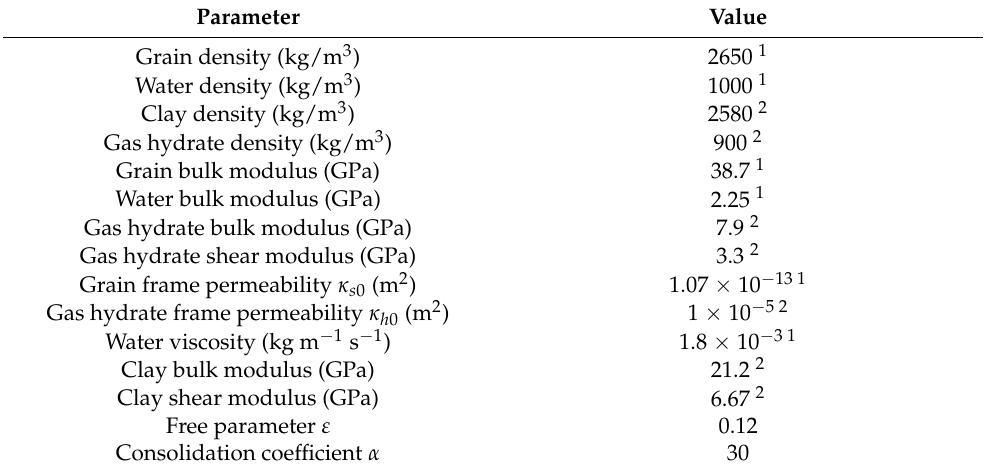
Table 1. Physical parameters of the model.